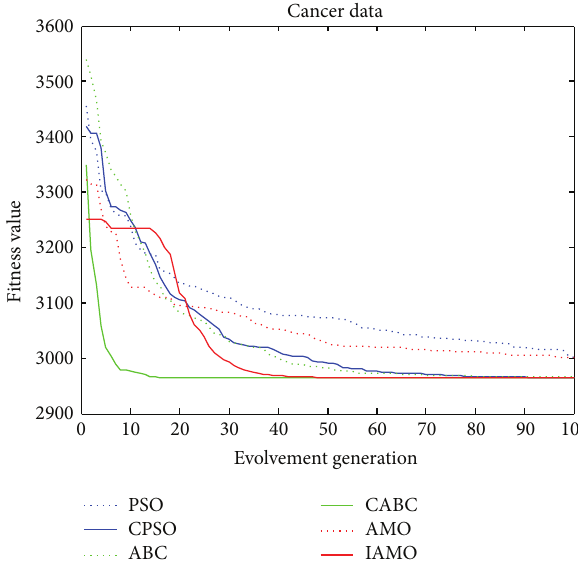
Figure 12: The convergence curve of the survival data.